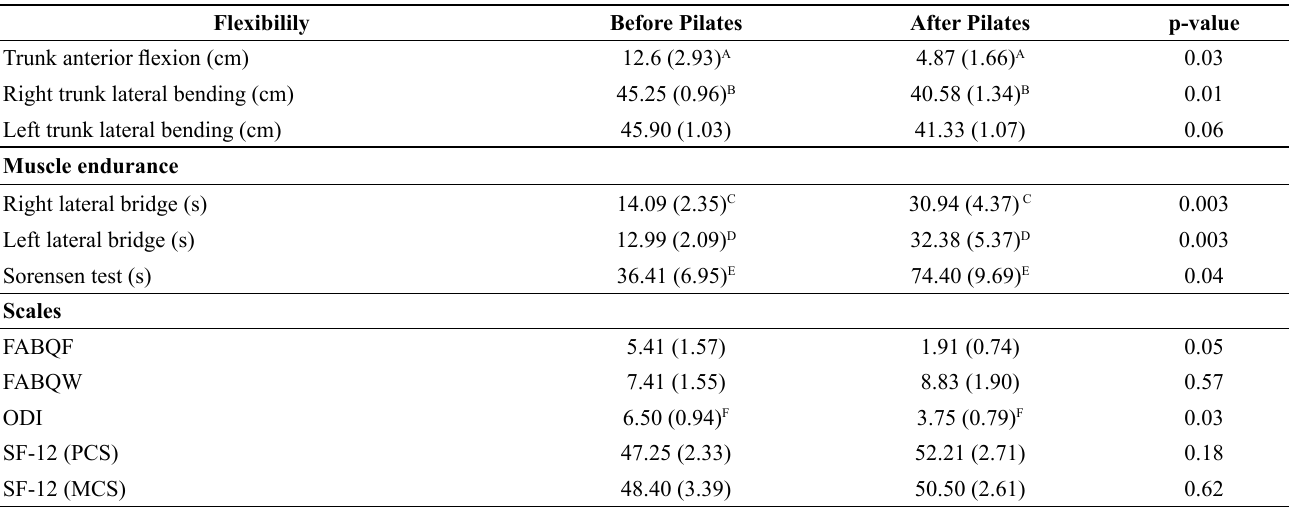
Table 1. Mean (standard error of measurement) of flexibility, muscle endurance and specific scales before and after the Pilates. Flexibilily Before Pilates After